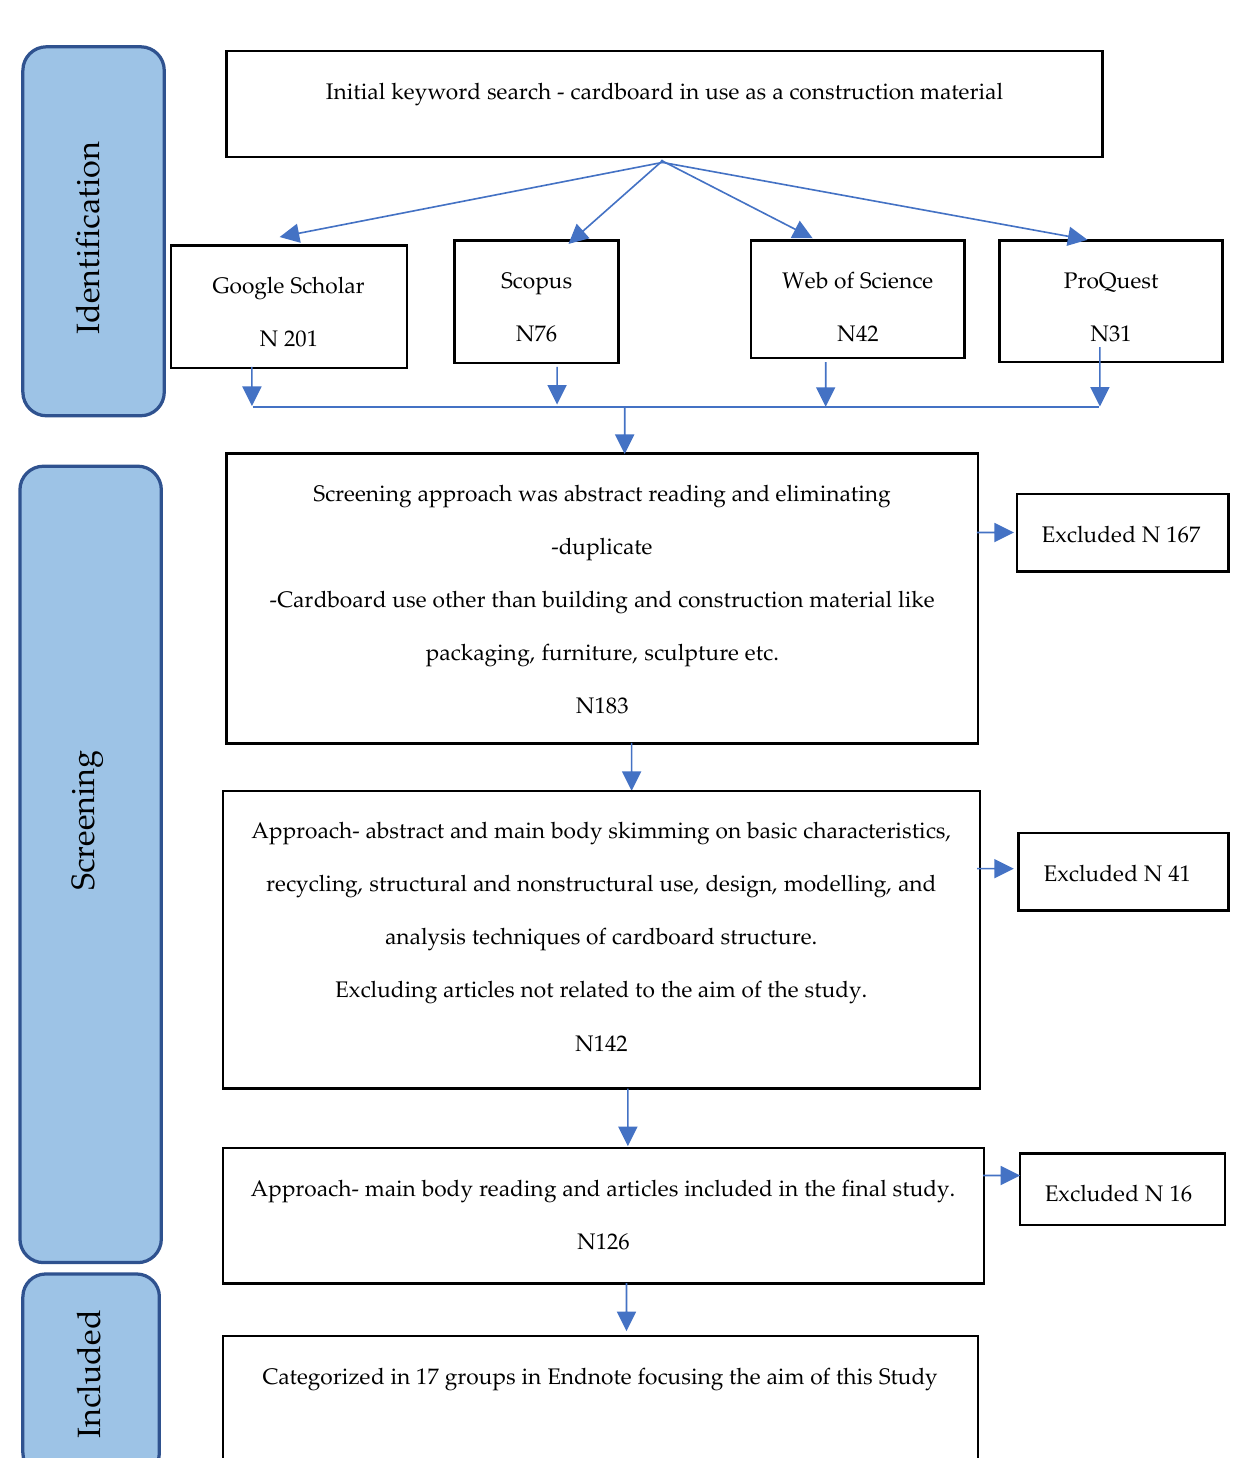
Figure 1. Systematic review approach of the study using a PRISMA diagram. Table 1. Sources of reviewed papers.